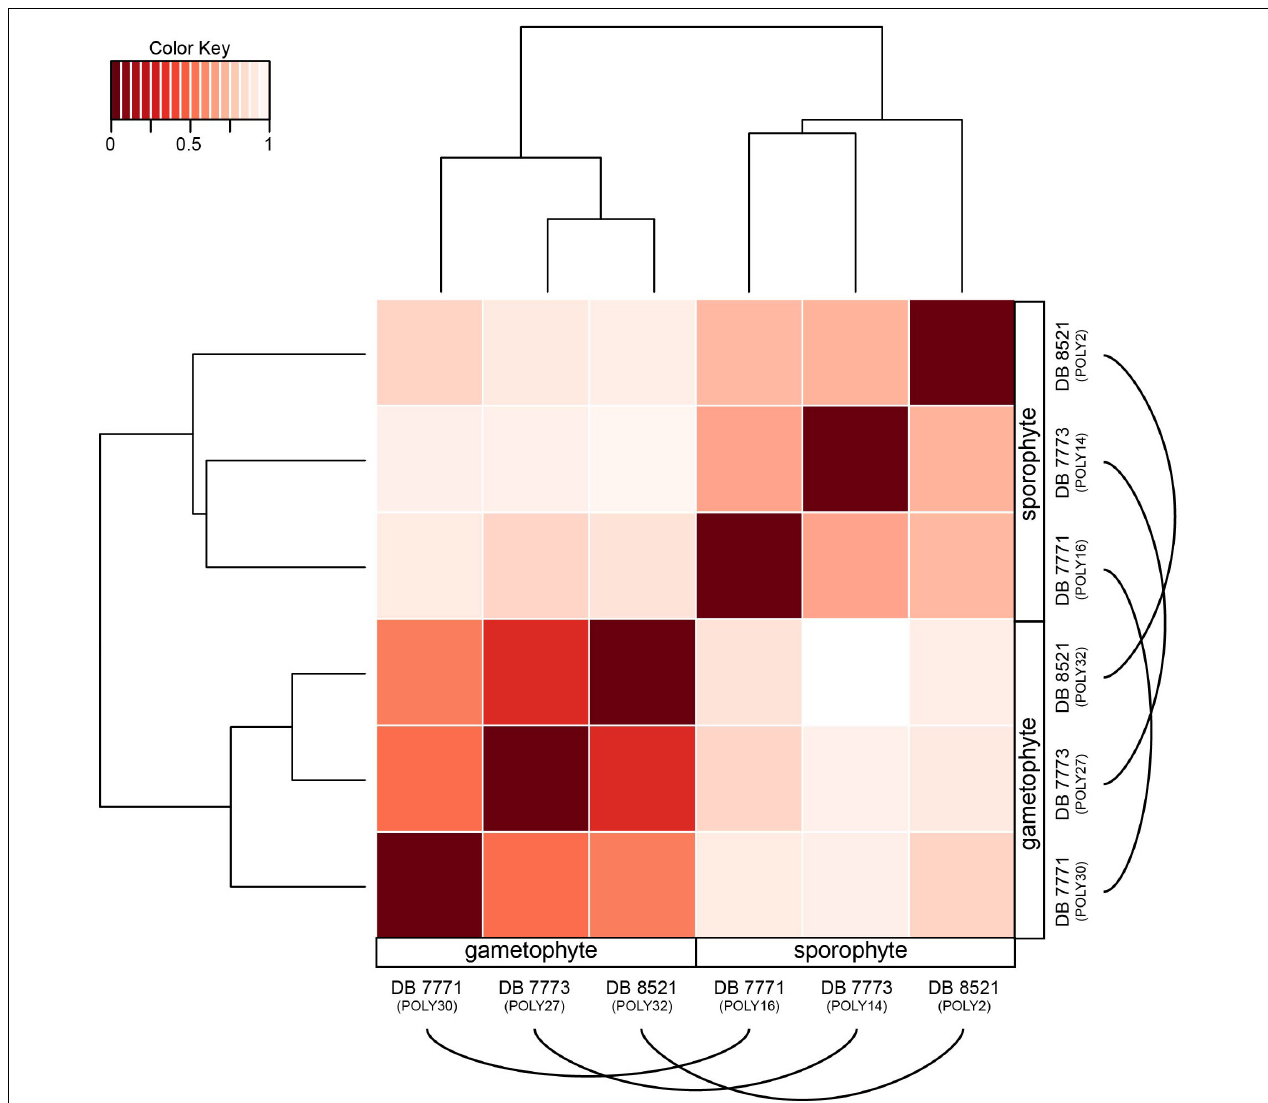
FIGURE 5 | Heat map showing the hierarchically clustered Euclidean distance matrix resulting from comparing the transcript expression values (log2-transformed FPKM + 1) for each pair of Polypodium amorphum samples. Samples are labeled as gametophyte or sporophyte, with an arched line connecting samples derived from the same P. amorphum